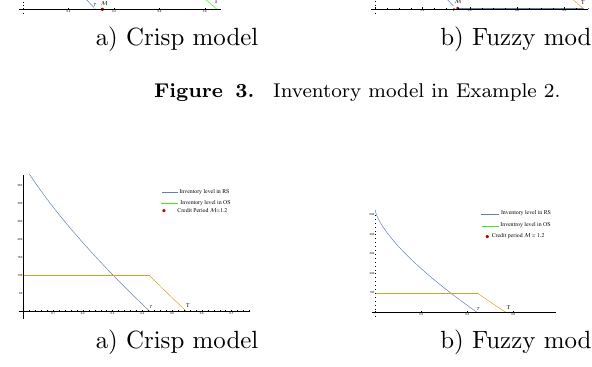
Figure 4. Inventory model in Example